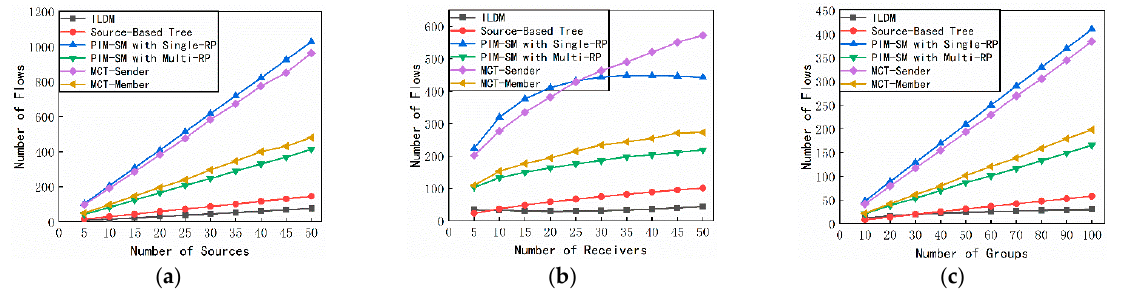
Figure 9. The comparison of link loads’ standard deviation. ( a ) The variation trends of link loads’ standard deviation with a different number of sources; ( b ) the variation trends of link loads’ standard deviation with a different number of receivers; ( c ) The variation trends of link loads’ standard deviation with a different number of